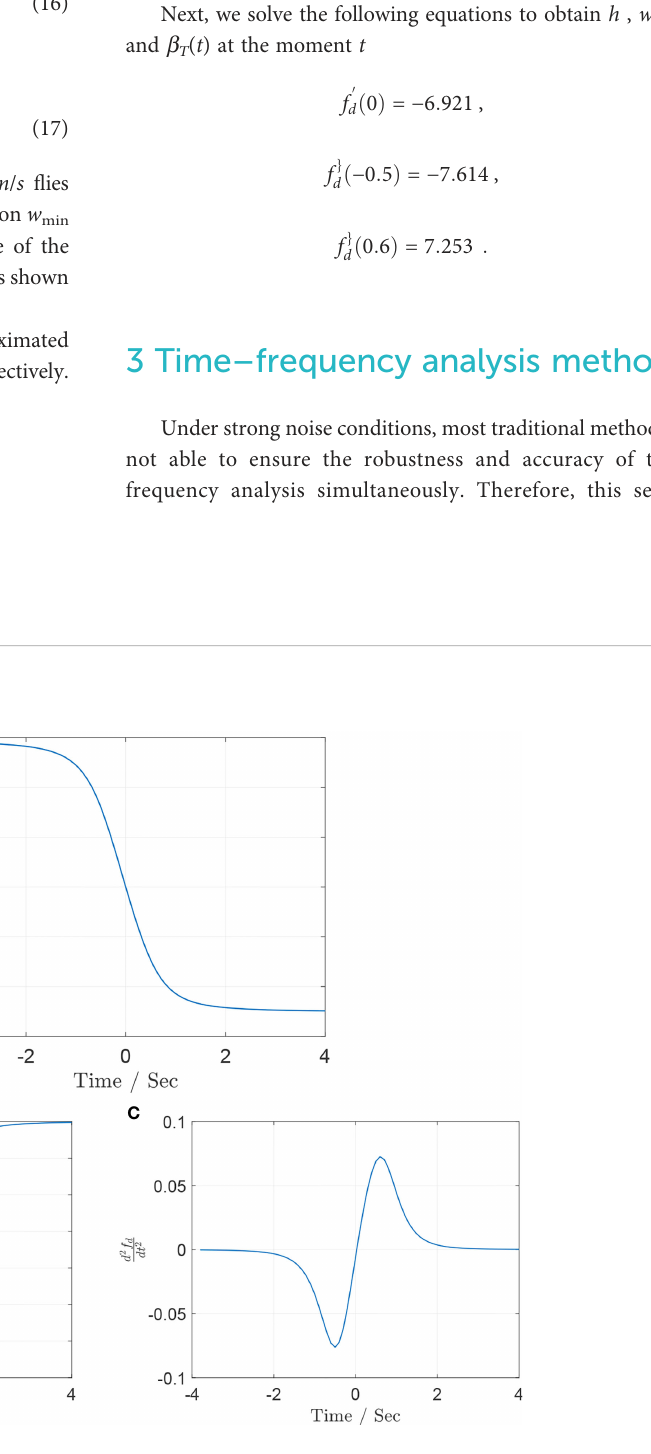
v = 123 m/s, h = 150 m, 0 = 68 m/s,